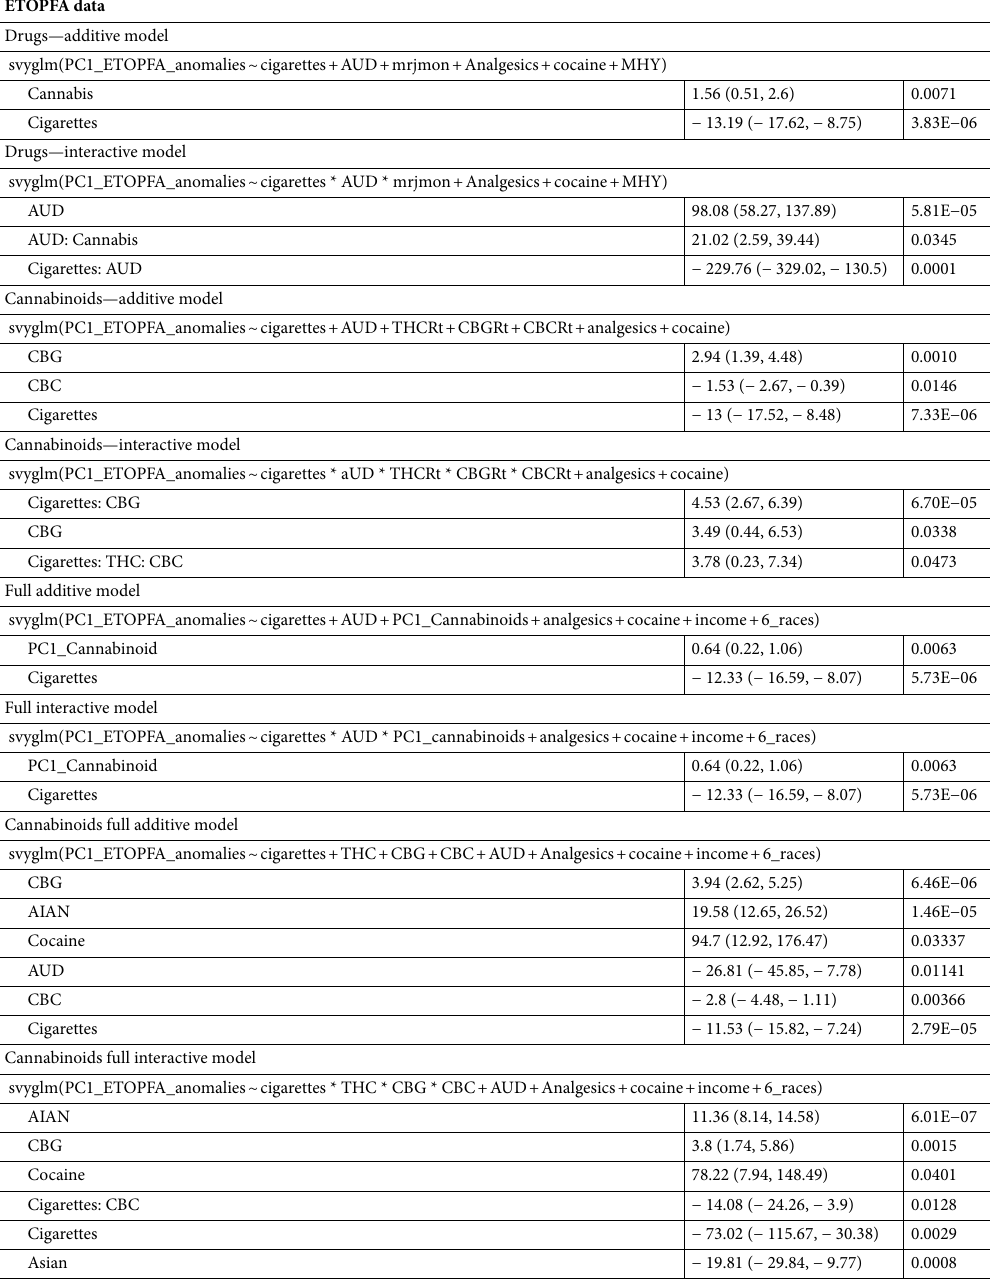
Table 3. Robust IPW-weighted generalized regression analyses on PC1 for ETOPFA-adjusted congenital anomaly data. Final robust generalized linear regression models for ETOPFACAR